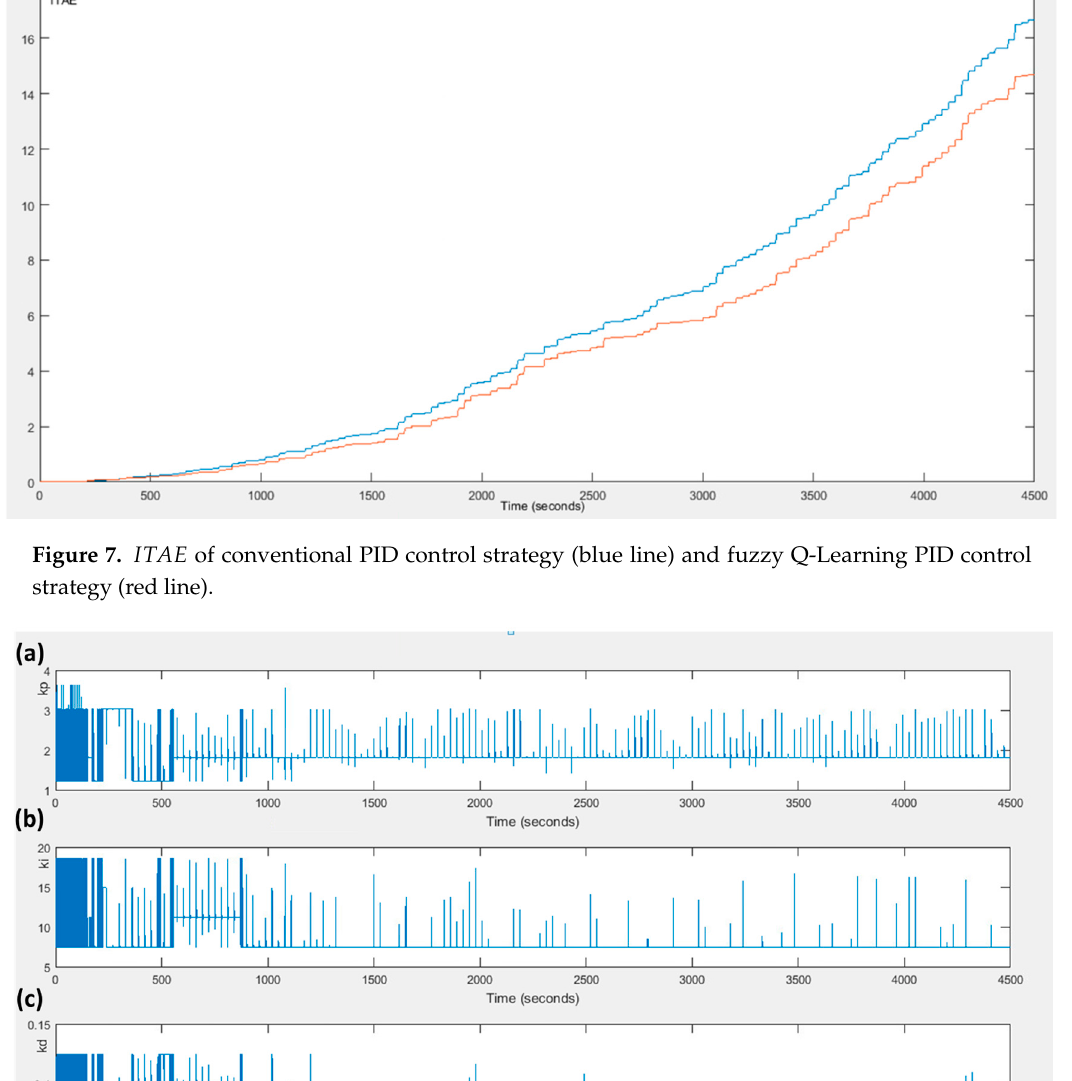
Figure 6. (cid:1835)(cid:1827)(cid:1831) of conventional PID control strategy (blue line) and fuzzy Q-Learning PID control strategy (red line).